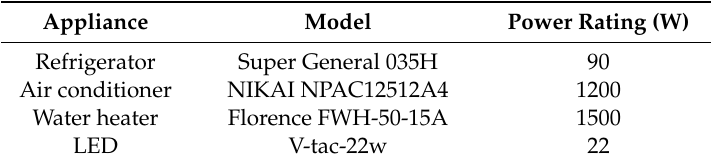
Table 1. Appliance details and specifications.